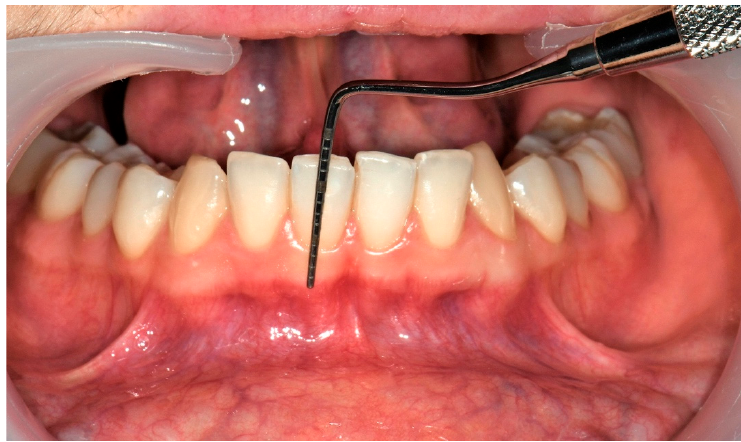
Figure 4. Measurement of width of keratinized gingiva .